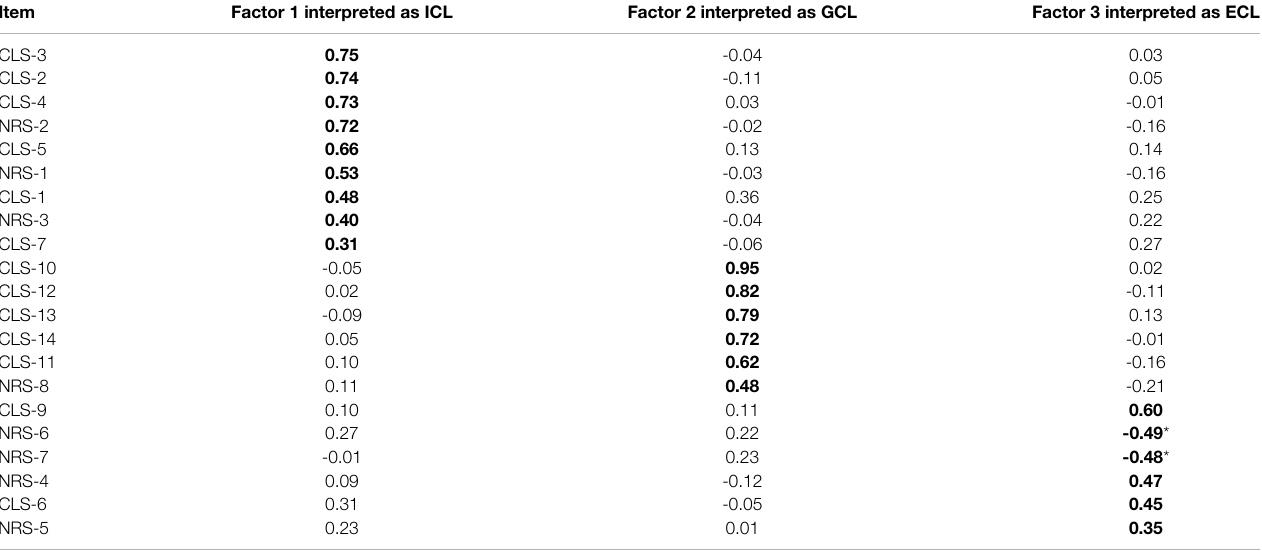
TABLE 5 | Results of the EFA for all items of both NRS and CLS. Item Factor 1 interpreted as